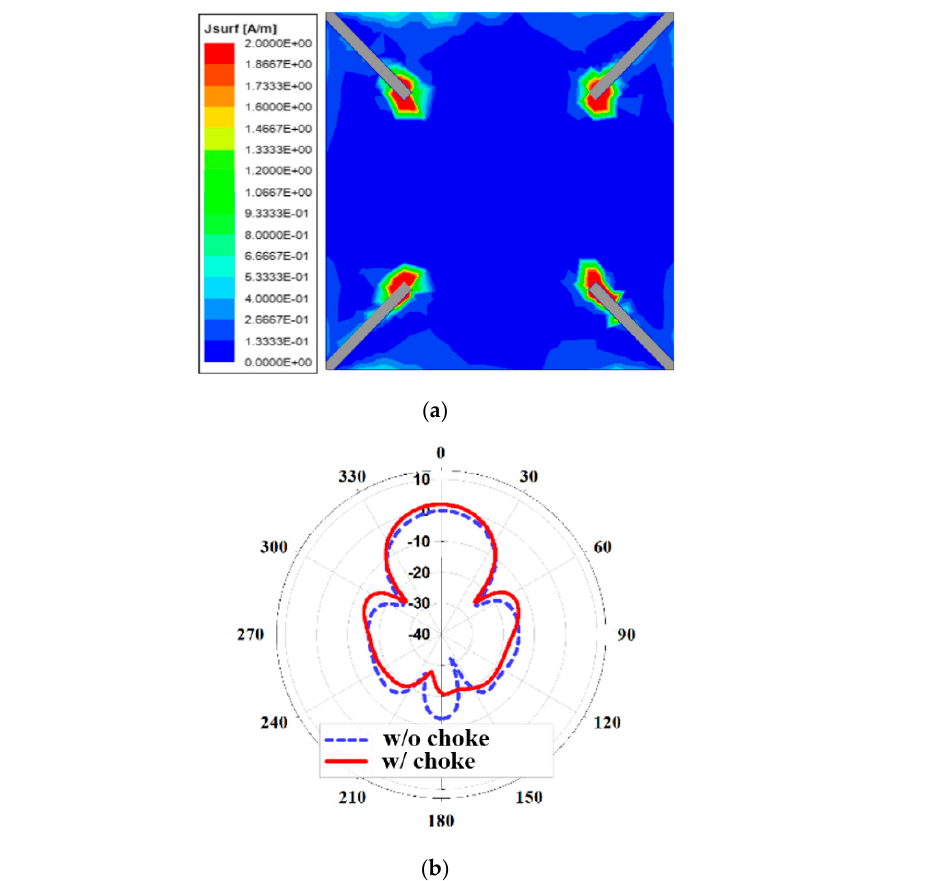
Figure 4. Effects of introducing diagonal choke points in the antenna ground: ( a ) simulated surface current density on the ground; ( b ) simulated E-plane radiation pattern with and without the choke.